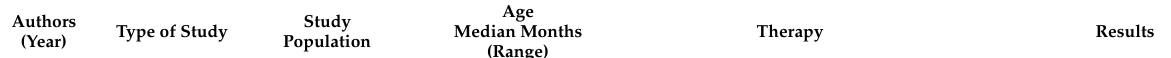
Table 4. Main studies on treatment and management of cat scratch disease (CSD)